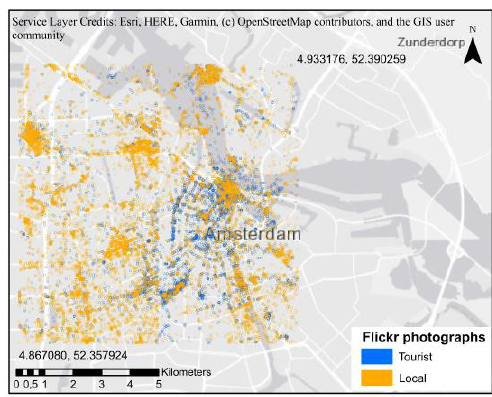
Figure 1 .Flickr photographs (Karayazi et al., 2021) Figure 1. represents the distribution of tourists’ and local photographs. The raw dataset contained 285.130 photographs which were taken between 1927 and 2019. We